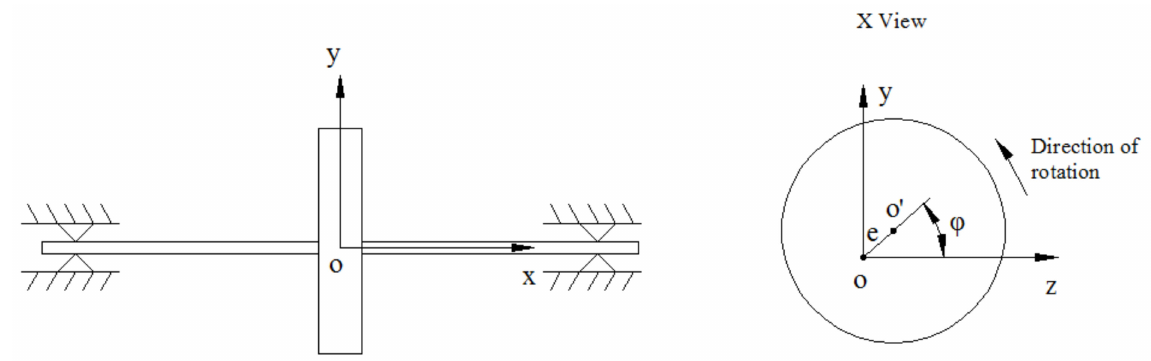
Figure 1. A rotating rotor whose axis is not coincident with the geometric axis. (x-the rotor’s rotation axis, o-the disk’s rotation center, o’-the disk’s geometric center, e-the disk’s eccentric distance, ϕ -the disk’s rotation phase